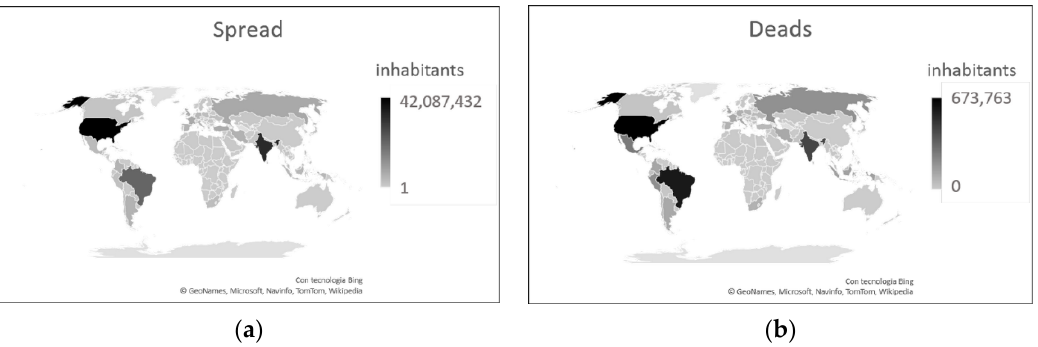
Figure 8. COVID-19 data as of 17 September 2021. ( a ) Number of cases. ( b ) Number of deaths. Both graphs show the extremely variability in the diffusion and severity of this disease.